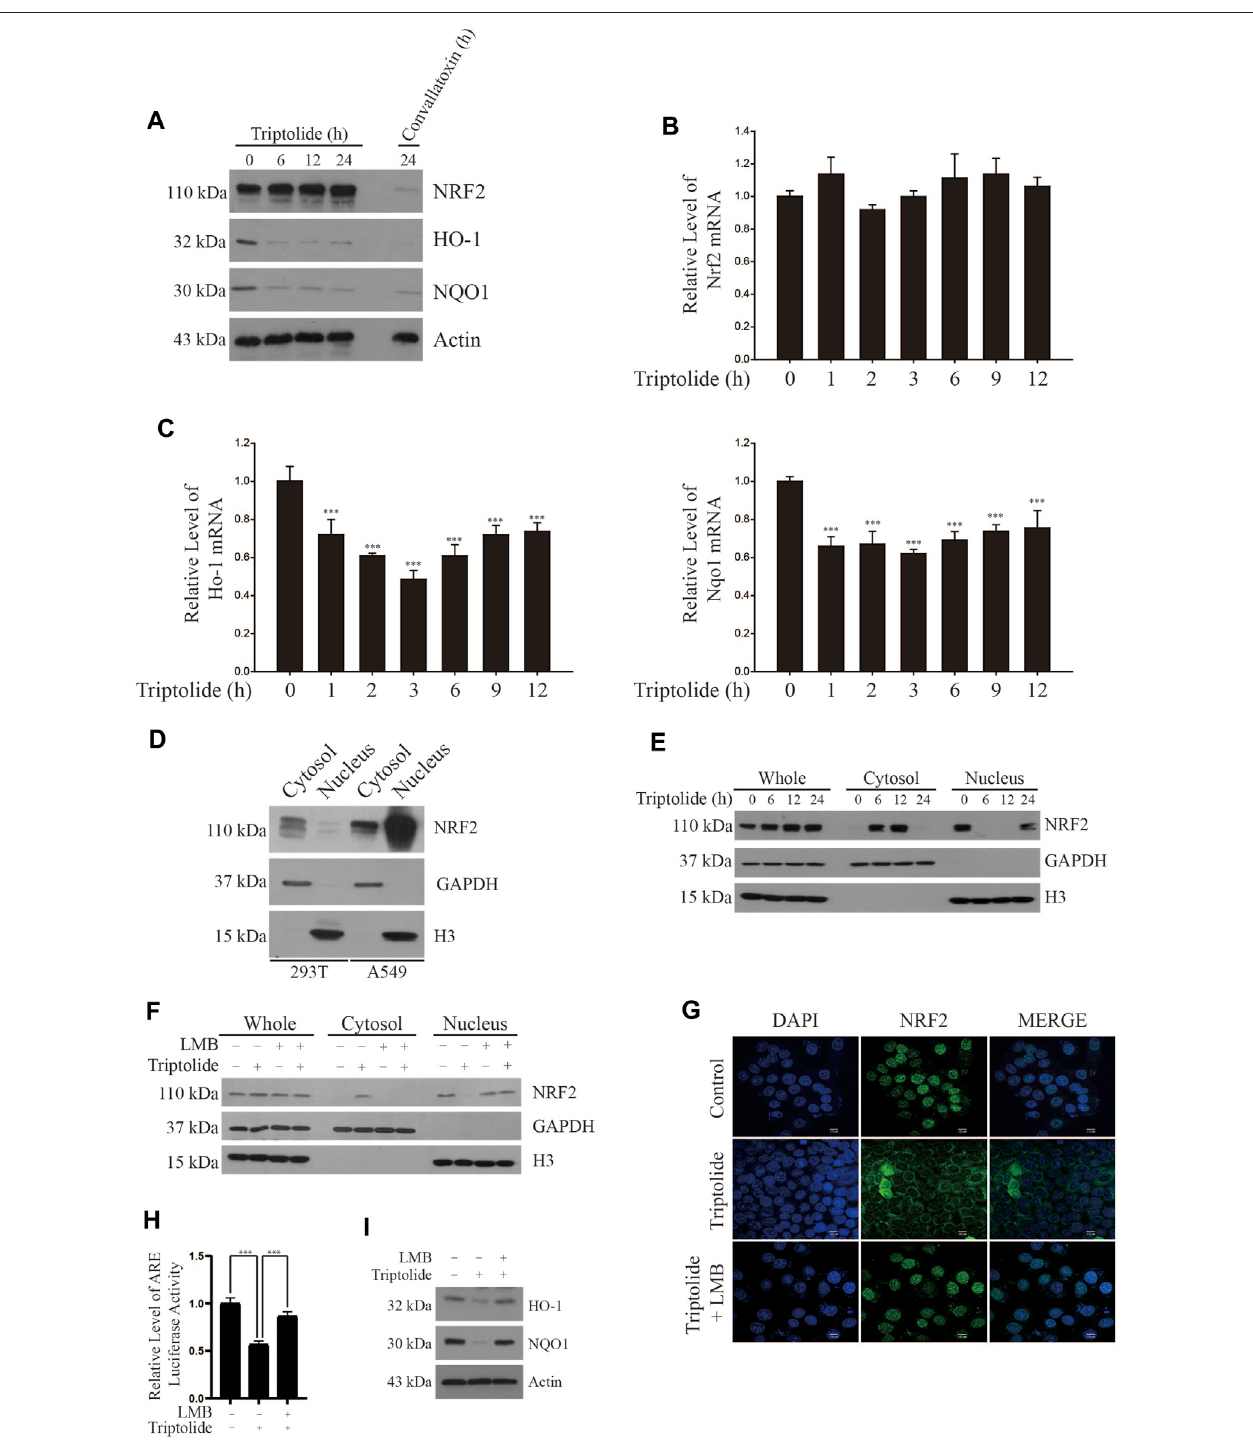
FIGURE2| TriptolideincreasescytoplasmiclocalizationofNRF2inA549cells. (A) TriptolidedoesnotaffectthelevelofNRF2,butsuppresstheexpressionofHO-1 and NQO1 in A549 cells. Convallatoxin was included as a positive control. A549 cells were seeded in 100 mm culture plates (2 × 10 6 cells) and exposed to triptolide (20 nM) for various amounts oftime. Western blot analysiswas performed against NRF2, HO-1, NQO1, and actin (B) Triptolide does notaffectthe level ofNrf2 mRNA in A549 cells. A549 cells were seeded in 6-well culture plates (2.0 × 10 5 cells/well) and exposed to triptolide (20 nM) for various amounts of time. Real-time RT-PCR was performed against Nrf2 mRNA ( n (cid:2) 4). (C) Triptolide signi fi cantly inhibits the mRNA levels of Ho-1 (Left Panel) and Nqo1 (Right Panel) in A549 cells. A549 cells were seeded in 6-well culture plates (2.0 × 10 5 cells/well) and exposed to triptolide (20 nM) for various amounts of time. Real-time RT-PCR was performed against Ho-1